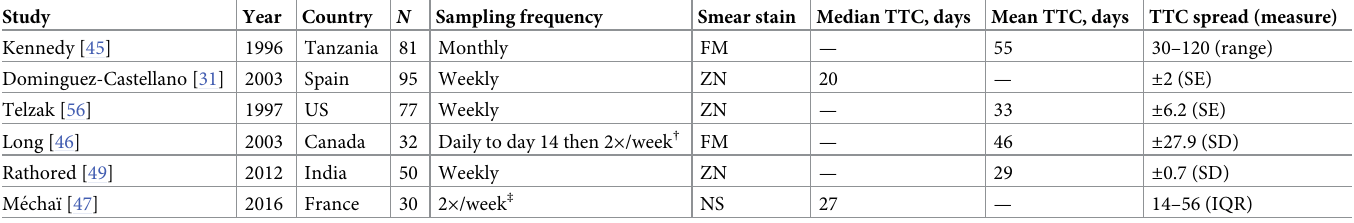
Table 4. Studies reporting a summary measure of time to smear conversion � AU : PleasechecktheeditstothecolumnheadsinTable 4 forcorrectness : .